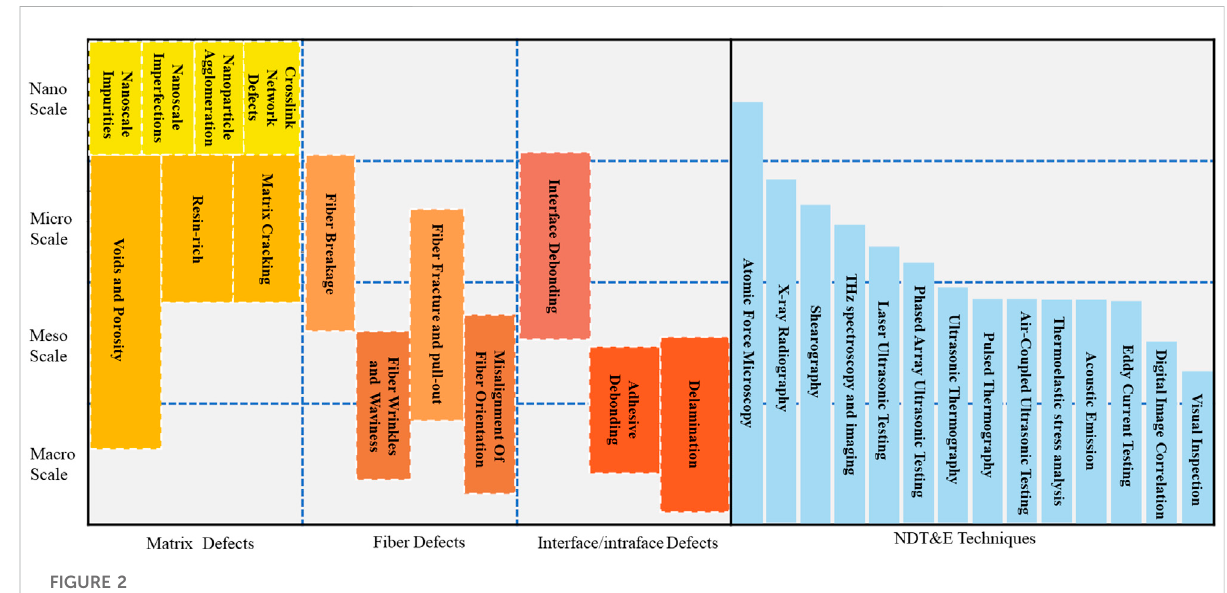
FIGURE 2 Classi fi cation of defects at different scales and the detection